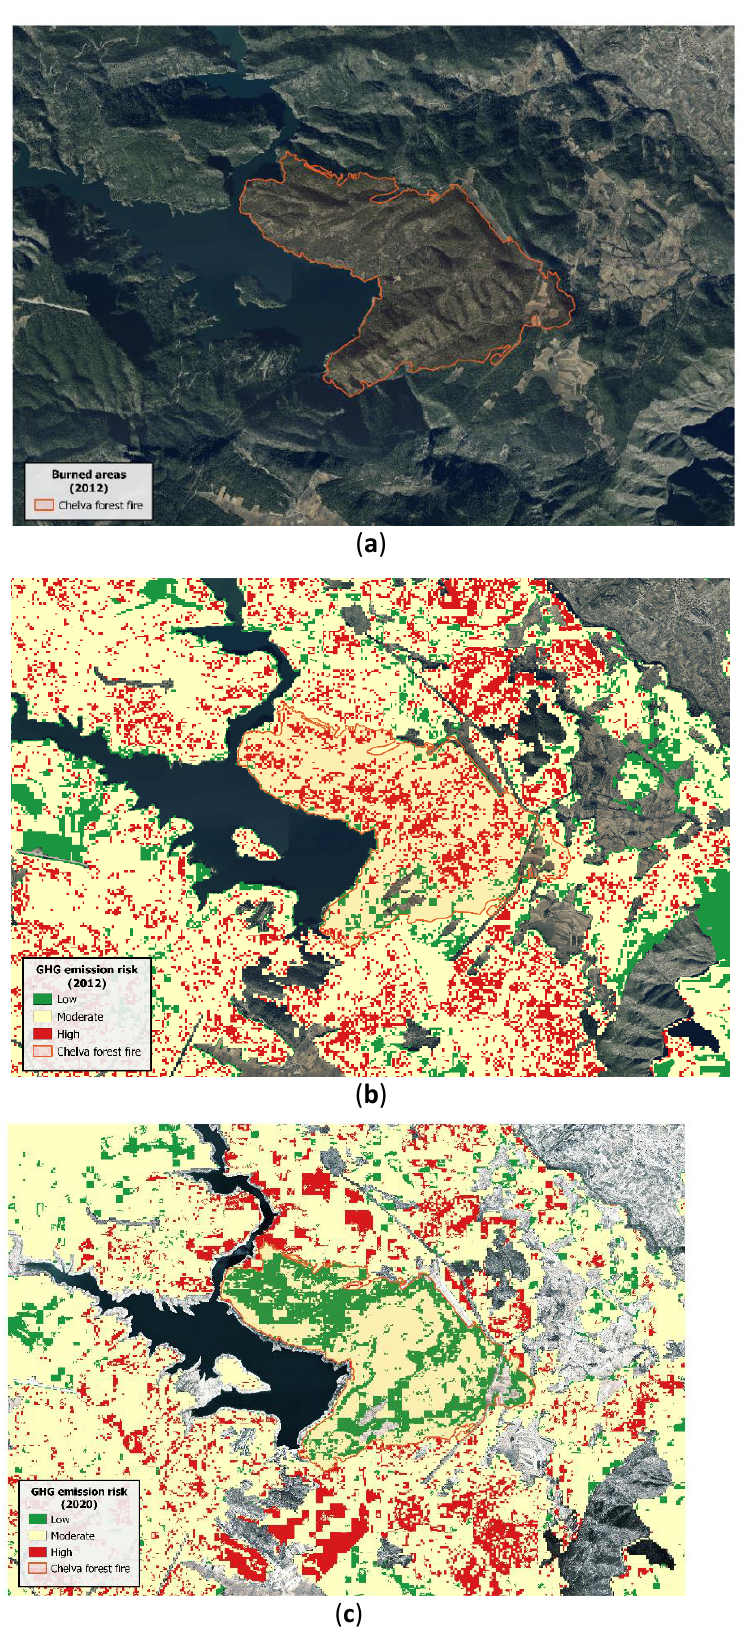
Figure 6. ( a ) Scaling up of Chelva forest fire (2010 orthophoto). ( b ) GHG emission risk in 2012. ( c ) GHG emission risk in 2020. ( c ) GHG emission risk in